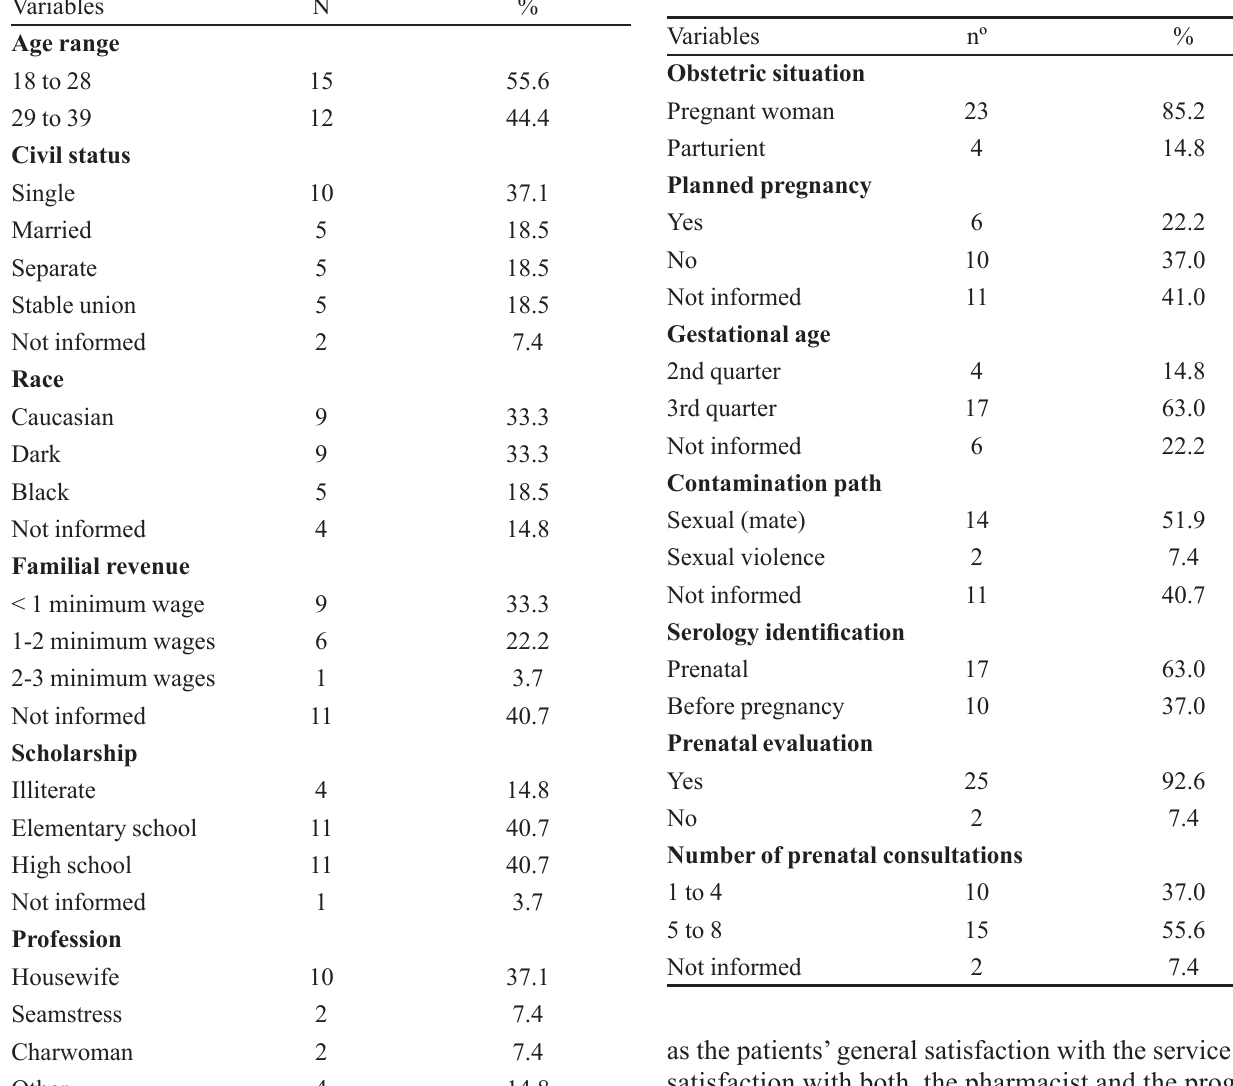
TABLE I - Distribution of patients carrying human immuno- deficiency virus (HIV), according to age range, civil status, race, familial revenue, scholarship, and profession (n=27)